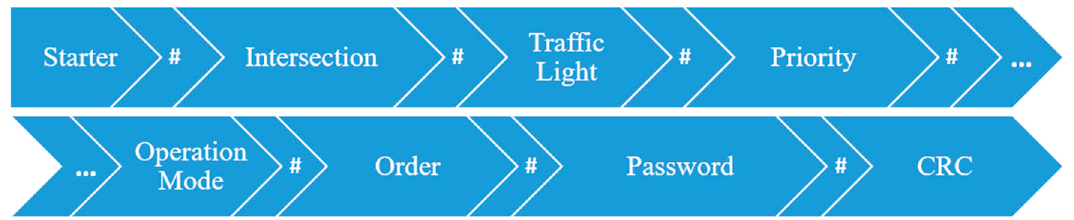
Figure 2. Diagram of vehicle priority parameters.